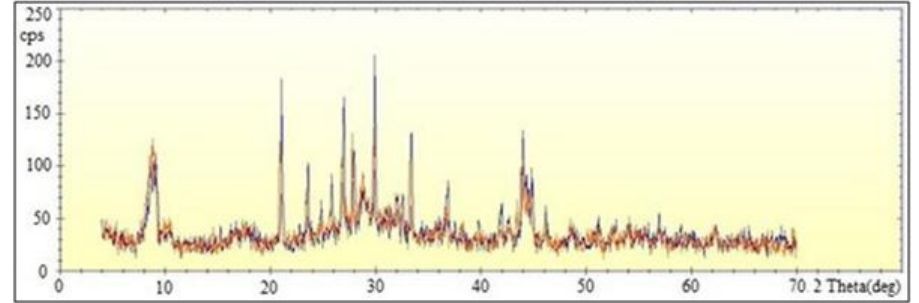
Figure 5. Comparative presentation of anode slime phase analyzes. Red represents the patterns at a temperature of T1 = 63 ± 2 °C, and blue represents the patterns at a temperature of T2 = 73 ± 2 °C for the anode with sample code An-1.